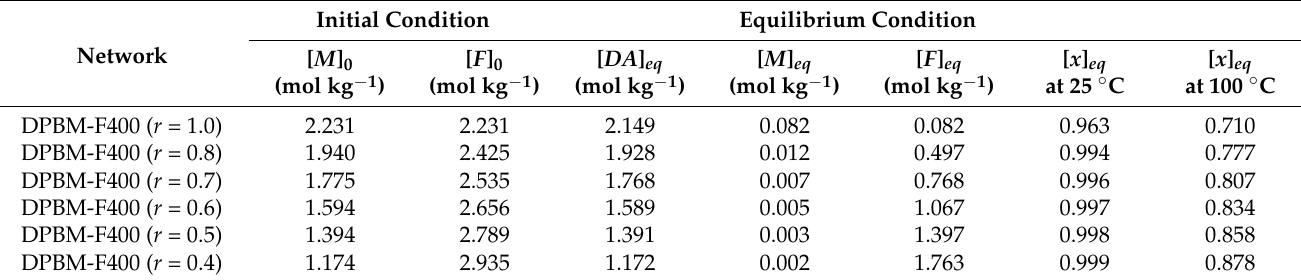
Table 1. Initial concentration of maleimide and furan, equilibrium concentrations of maleimide, furan and Diels–Alder cycloadducts at 25 ◦ C, and equilibrium conversions at 25 and 100 ◦ C of synthesized DA polymeric networks with different maleimide to furan ratios ( r ). Initial Network